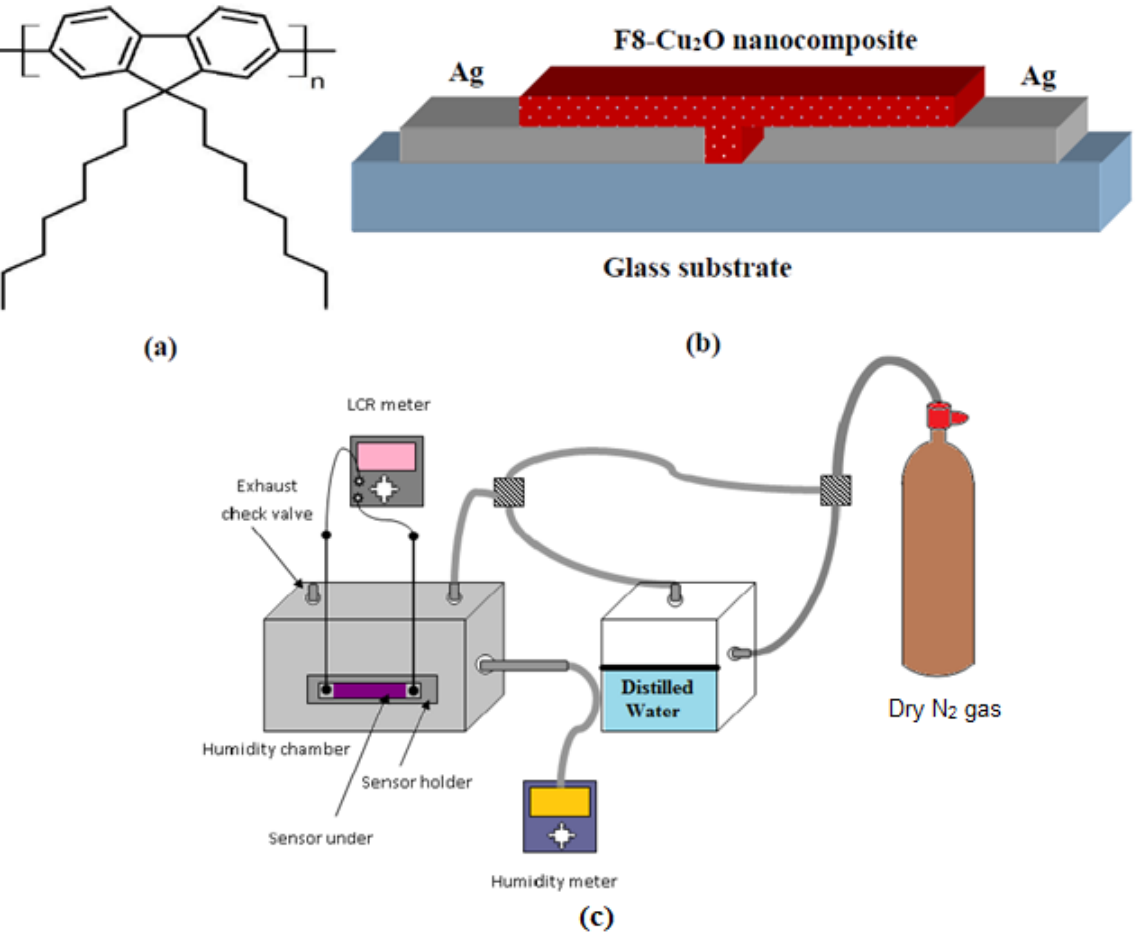
Figure 1. ( a ) Molecular structure of F8, ( b ) Schematic structure of Ag/F8-Cu 2 O/Ag sensor, ( c ) Schematic diagram of self-developed humidity sensing set up.